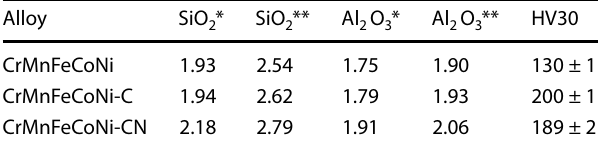
Table 4 Wear resistance W − 1 x10 4 pin-on-paper against SiO2 (900– mesh